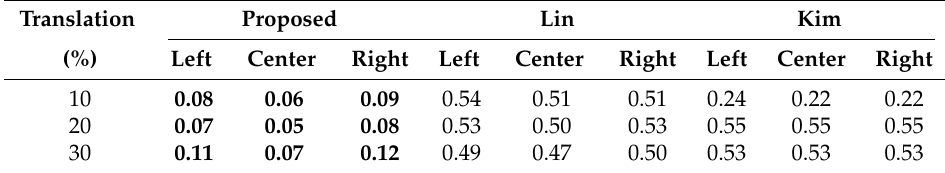
Table 11. Average BER for translation attack.